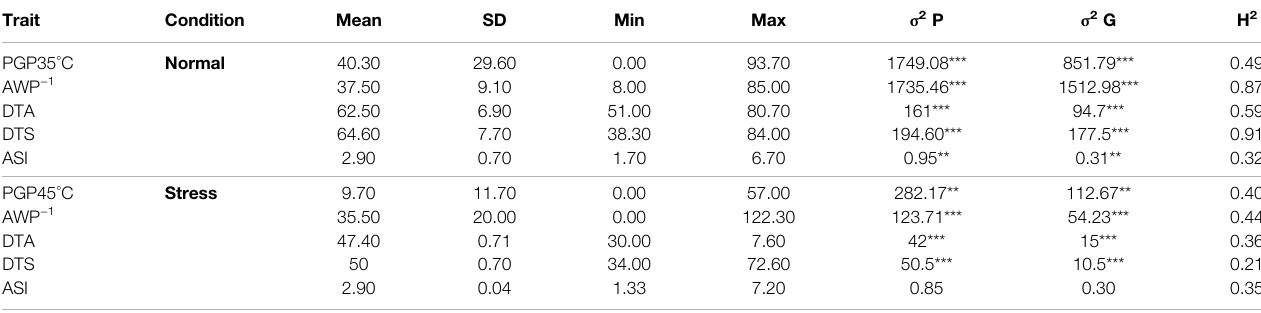
TABLE1| Descriptivestatisticsofvariousgeomorphologicaltraitsinsubsetof122diversemaizeinbredlinesplantedundernormalandheatstressconditionsacross2 years (spring 2017 and 2018) at Islamabad (NARC).